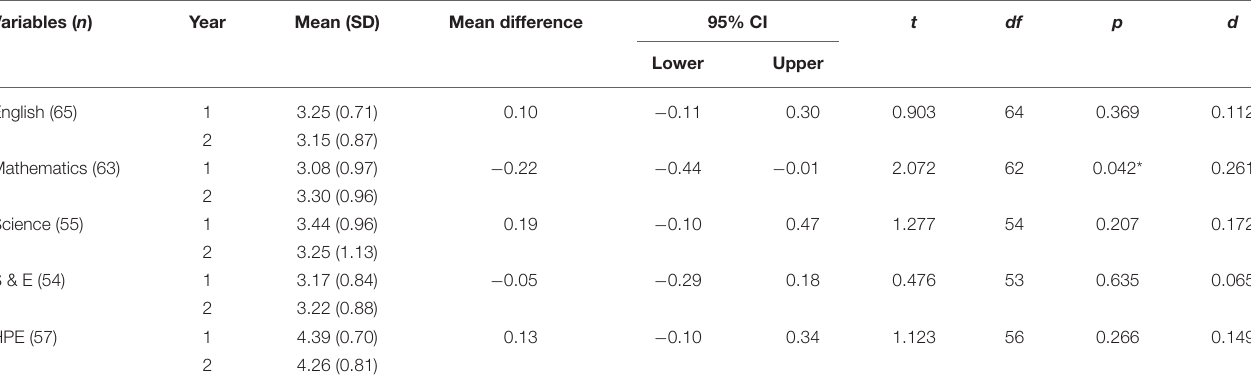
TABLE 2 | Descriptive statistics and t -test results for specialist students’ academic performance. Variables ( n